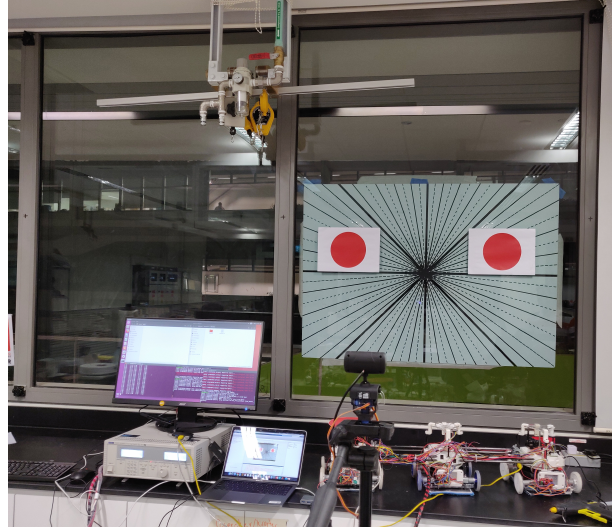
Figure 15. Test bed layout for sensor calibration in static